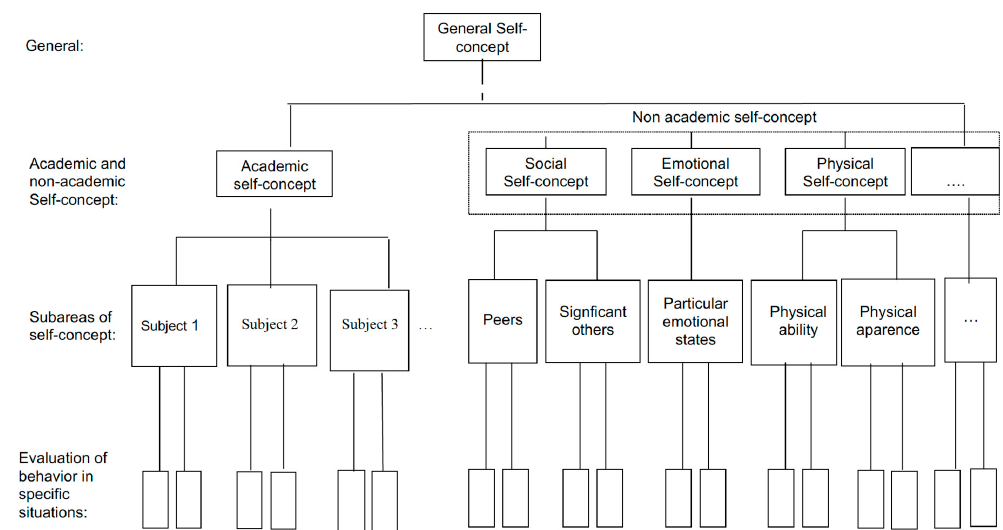
Figure 1. Representation of a multidimensional, hierarchical model (Adapted from: Shavelson, Hubner and Stanton [41], p. 413; original version copyright is the American Educational Research Association).